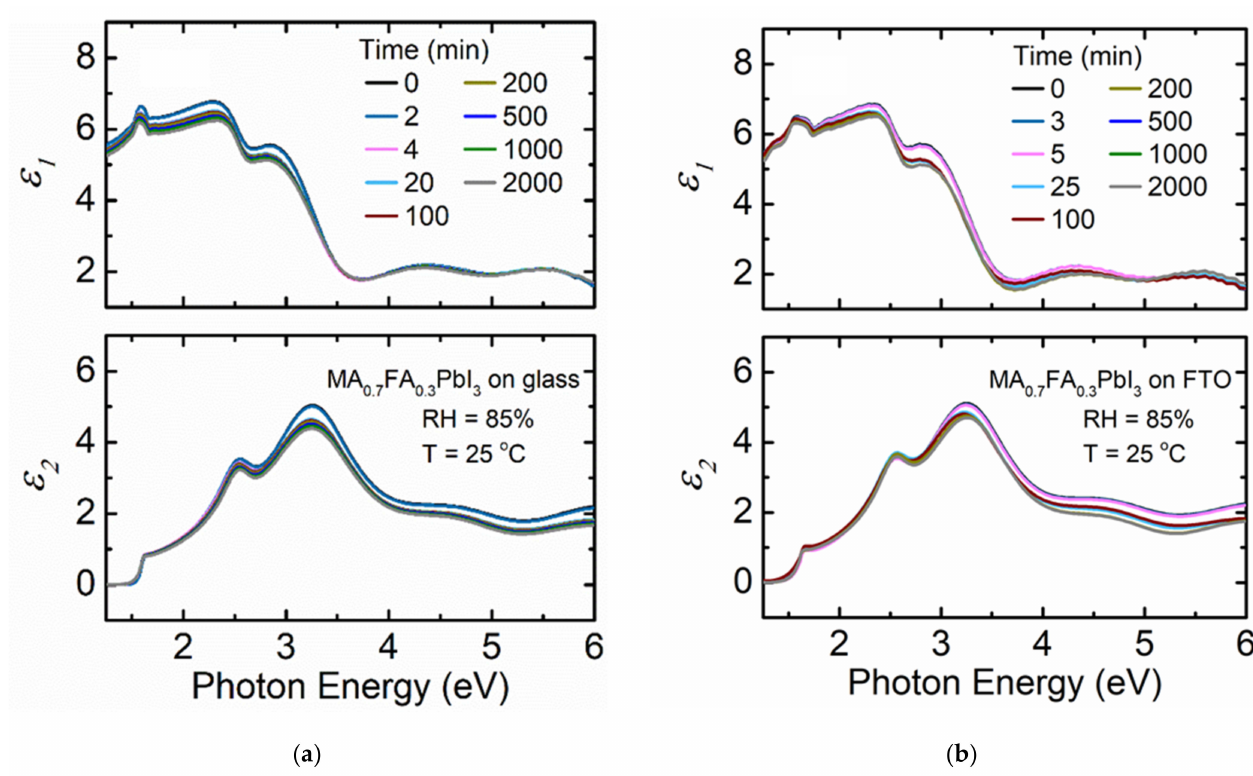
Figure 4. Spectra in ε at selected time points for thin film MA 0.7 FA 0.3 PbI 3 deposited on ( a ) soda lime glass and ( b ) FTO coated glass when exposed to 85% RH at 25 ◦ C. RH is introduced at 4 and 5 min for ( a ) and ( b ),